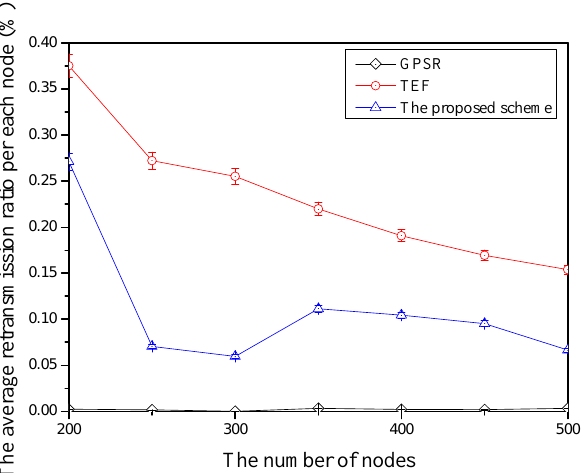
Figure 8. The comparison of the average retransmission ratio per node according to the number of nodes